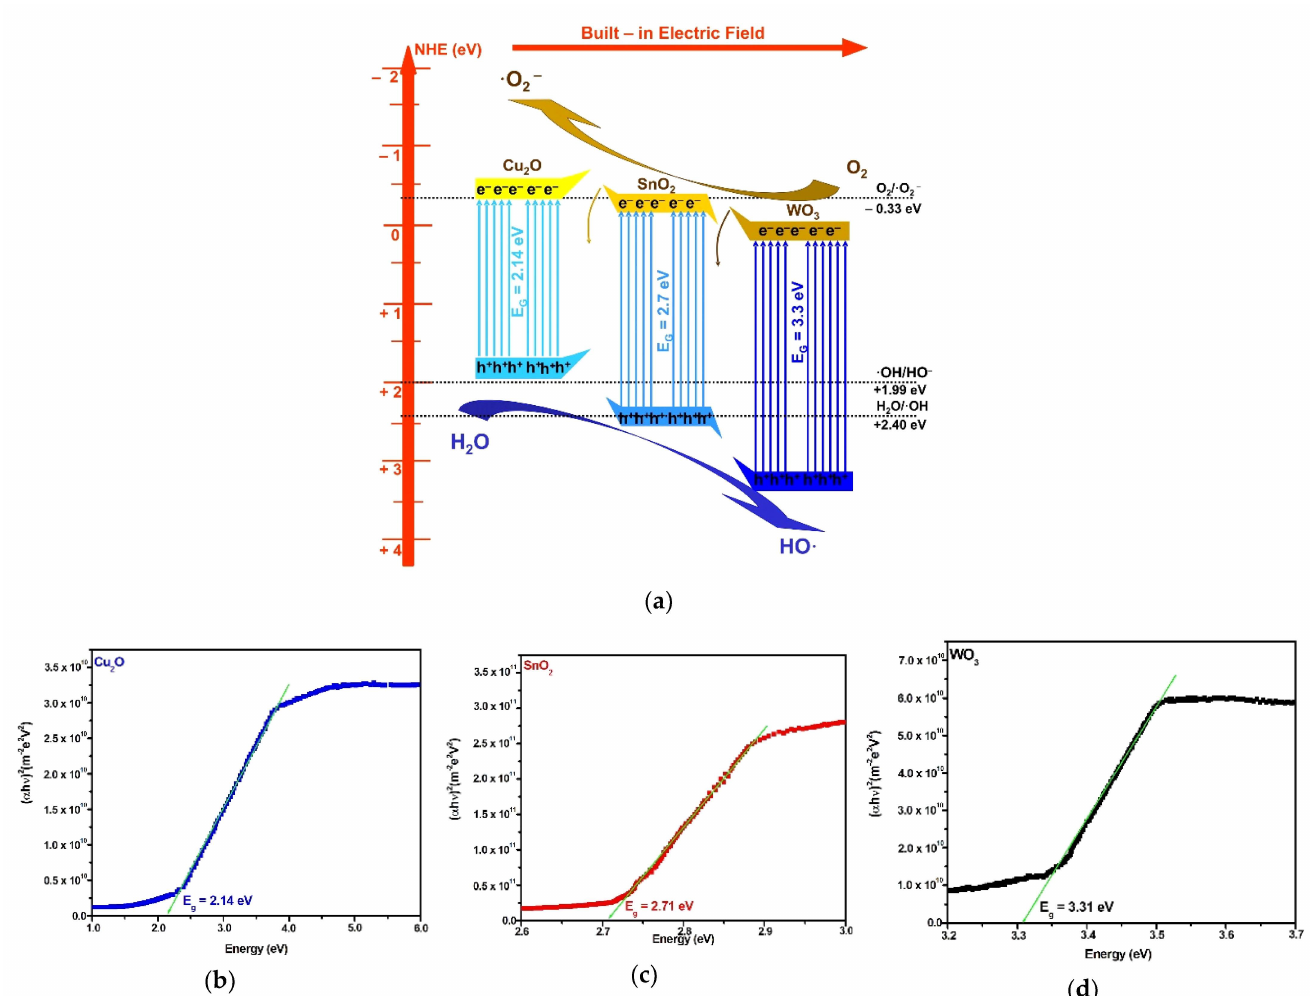
Figure 6. Heterostructure mechanism ( a ) and component band-gap values ( b – d ).